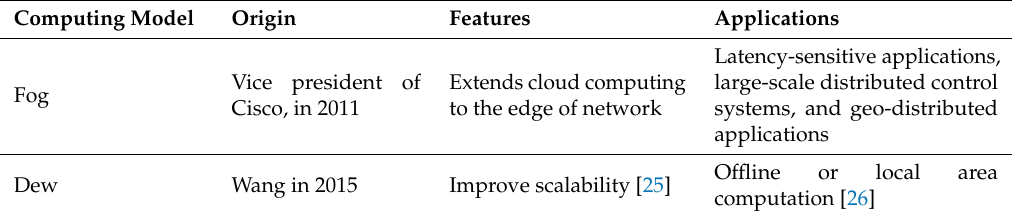
Table 1. Comparative analysis between fog and dew computing.